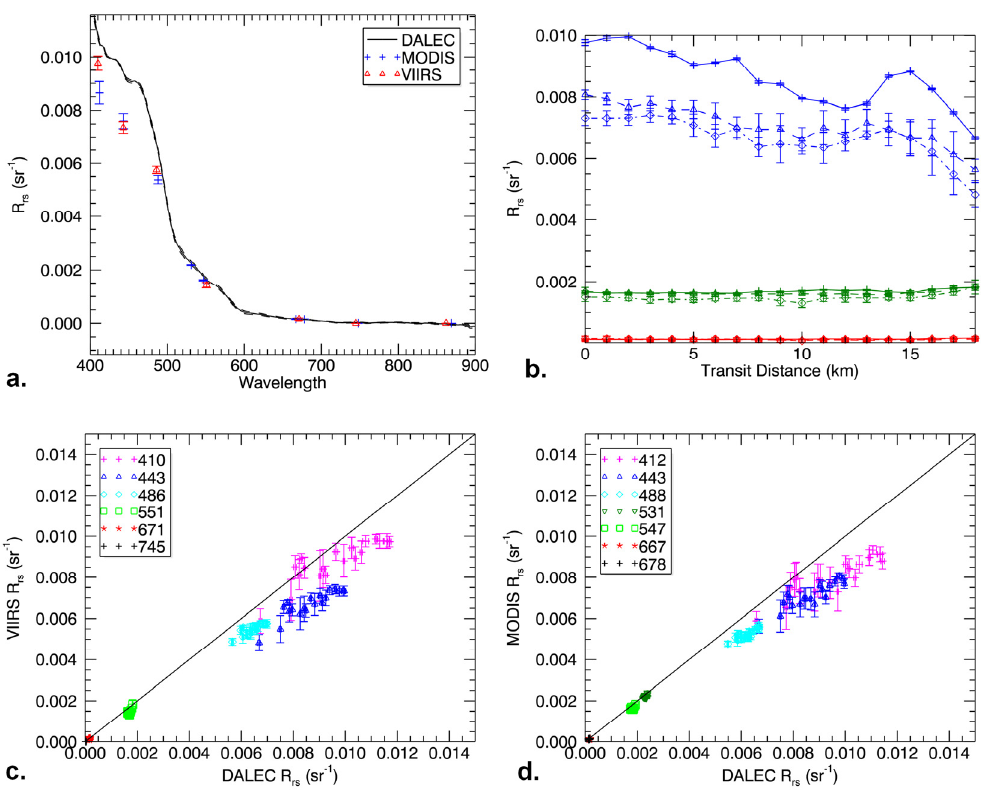
Figure 4. Spectral comparison at 1km scale between DALEC, VIIRS and MODIS acquired at Scott Reef on 12 April 2015. ( a ) DALEC, VIIRS and MODIS mean and standard deviation (DALEC standard deviation shown as dashed lines); ( b ) Transect plot of DALEC (+), VIIRS (triangle) and MODIS (diamond) at three spectral bands: the blue (443 nm), green (DALEC and VIIRS, 551 nm; MODIS 547 nm) and red (DALEC and VIIRS, 671 nm; MODIS 667 nm); ( c ) DALEC and VIIRS data; ( d ) DALEC and MODIS data. Black line is 1:1 in both ( c ) and ( d ). In all cases, error bars on DALEC data represent the standard deviation over the aggregation period and error bars on satellite data indicate the standard deviation over a 3x3 neighborhood of pixels. Table 3. Spectrally aggregated match-up summary statistics. N is the number of pixels used in the statistical calculations.